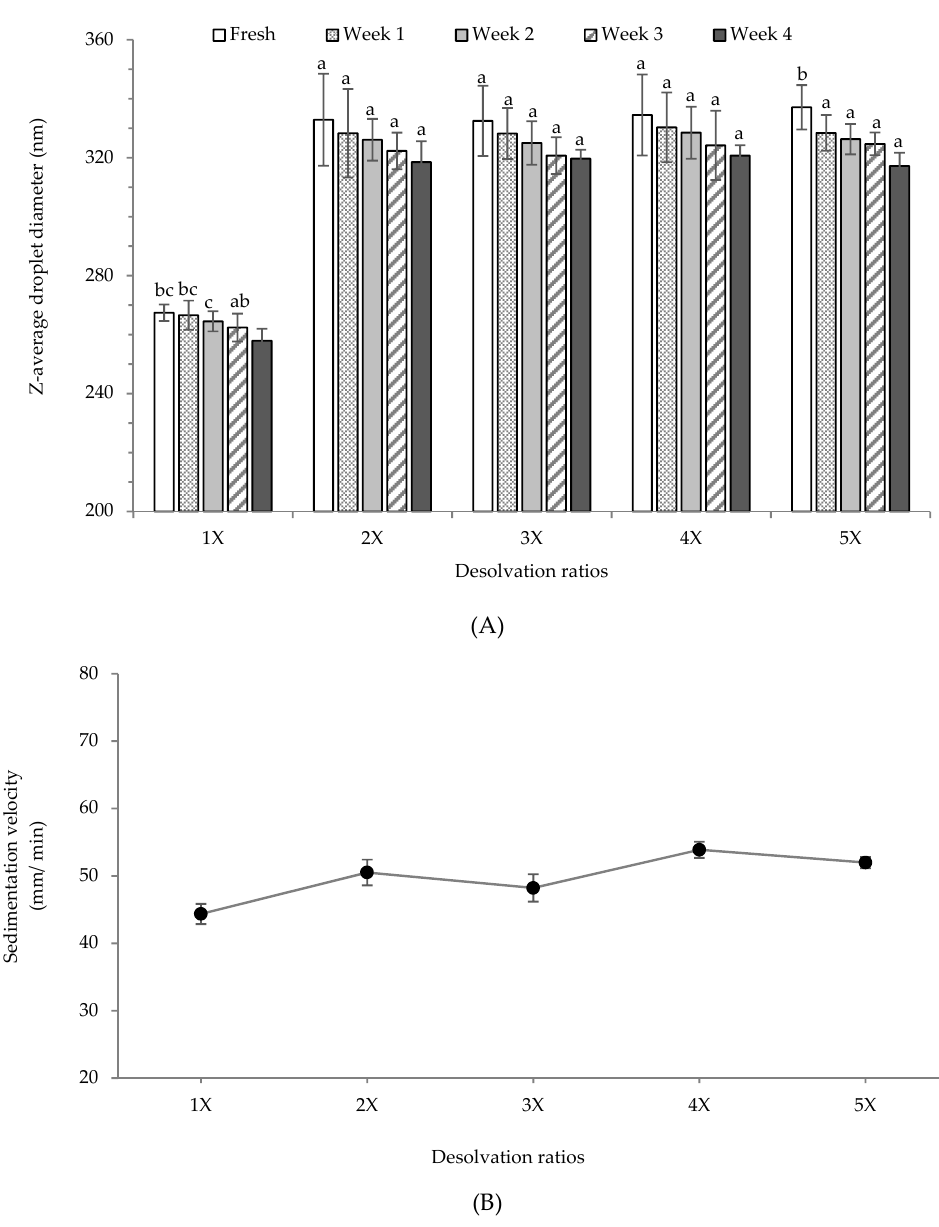
Figure 6. ( A ) Storage stability of re-dispersed pea protein nanoparticles prepared with different ethanol desolvation ratios at pH 7, ( B ) sedimentation velocity (µm/ min) of the freshly re-dispersed pea protein nanoparticles at pH 7 under accelerated gravitation (1000 rpm, ~130 g).